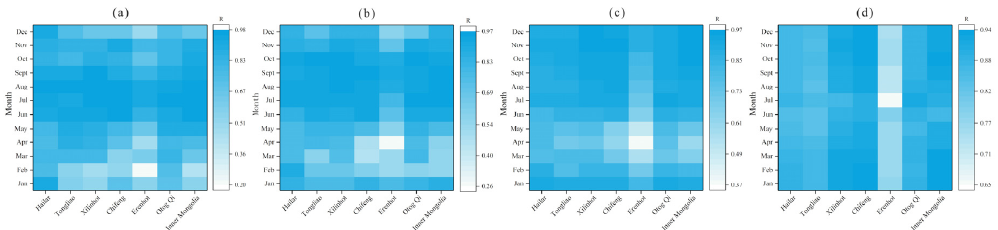
Figure 7. The correlations between the SPI and SPEI of typical meteorological stations at 1-, 3-, 6-, and 12-month timescales. ( a ) 1-month, ( b ) 3-month, ( c ) 6-month, and ( d ) 12-month timescales. All and12-monthtimescales. ( a )1-month,( b )3-month,( c )6-month,and( d )12-monthtimescales. Allcoefficients coefficients are significant with p < 0.05. are significant with p <